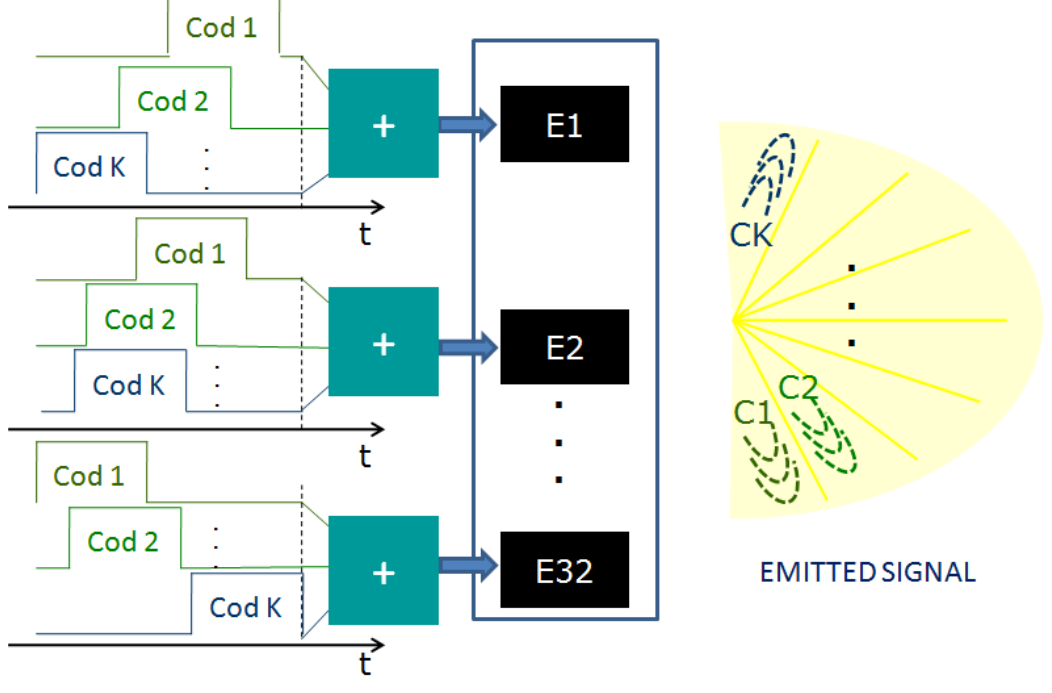
Figure 6. Detail of the emission stage: Each element is driven by the sum of the K delayed codes.